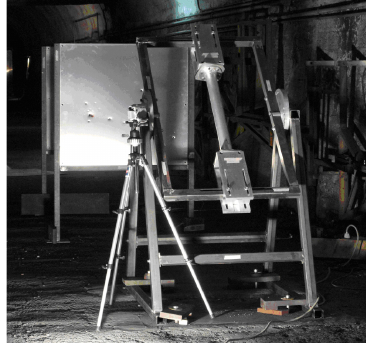
Figura 5: Il proiettile 7.62 NATO; inferiormente solo la “pallottola” estratta dal